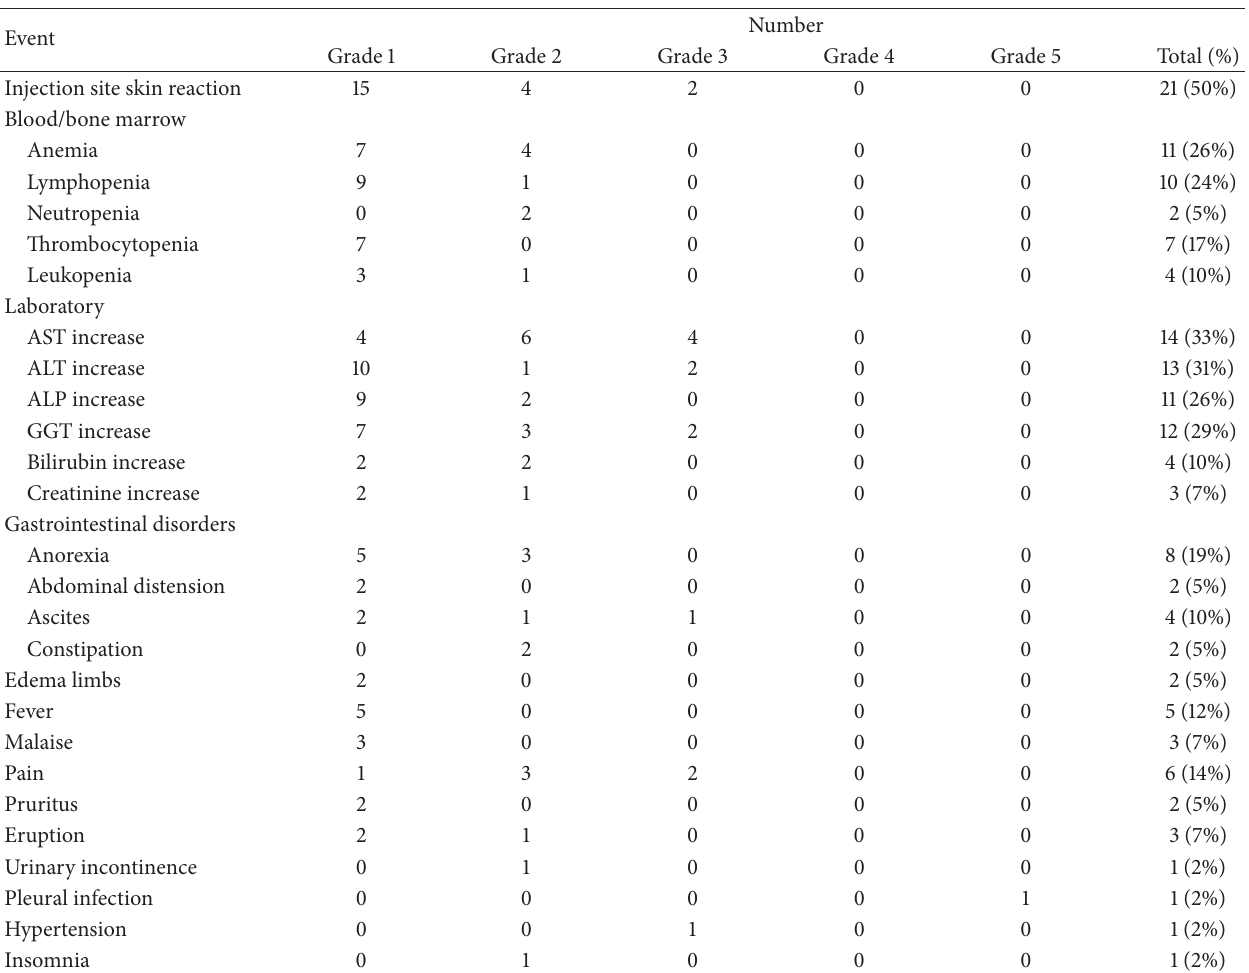
Table 2: Adverse events during the PPV ( 𝑛 = 42